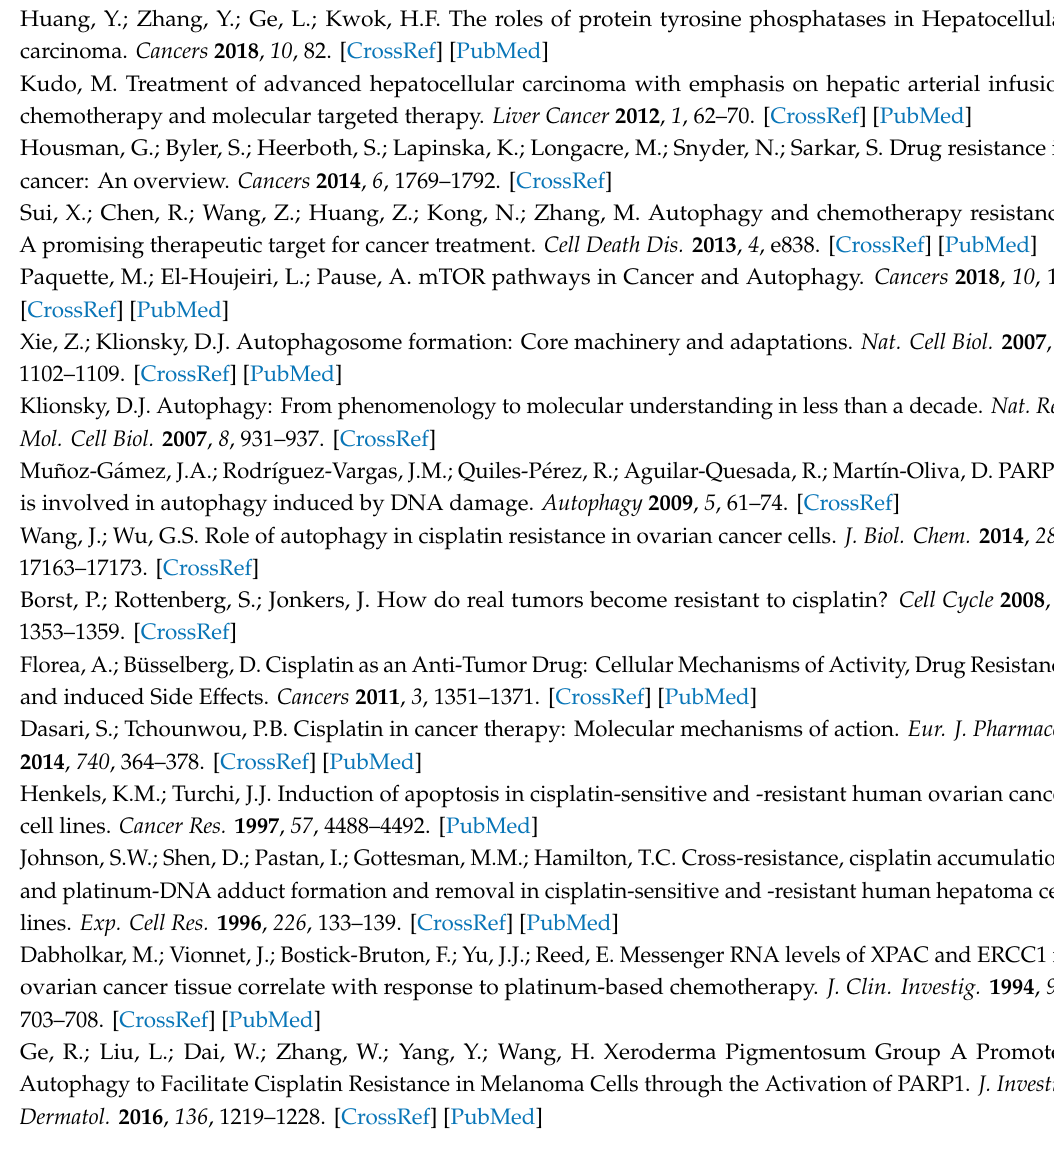
Table S1: List of antibodies for Western blot analysis, Table S2: Sequences of RT-PCR oligonucleotide primers, Table S3: Sequences of SiRNA for